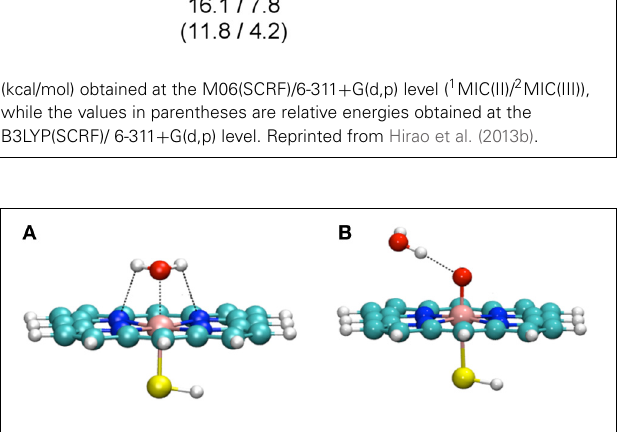
FIGURE 8 | (A) The resting state of the P450 catalytic cycle (B) Cpd I interacting with a water molecule. Reprinted from Thellamurege and Hirao